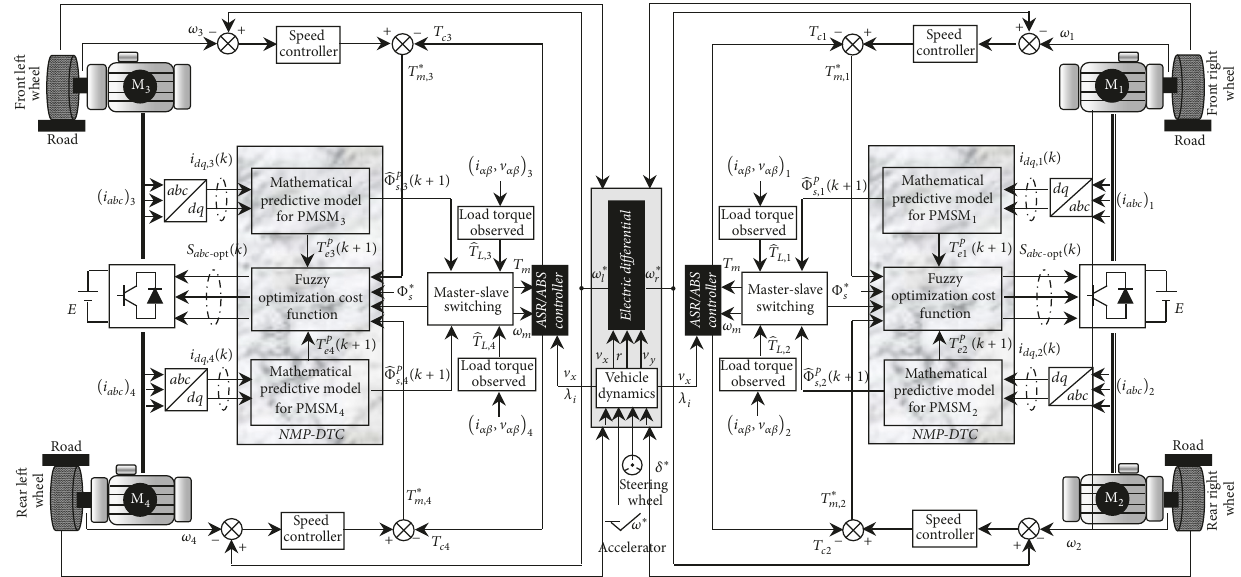
Figure 14: Block diagram of the longitudinal control of 4WID electric vehicle based on a new master-slave NMP-DTC technique.